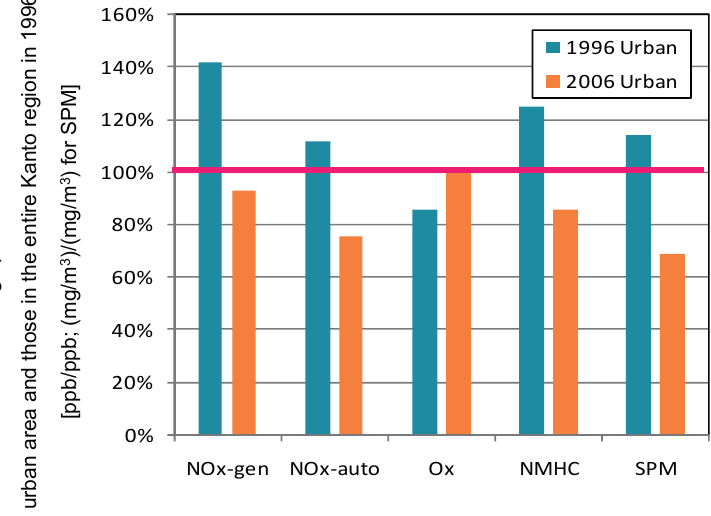
Figure 10. Ratio between average pollutant concentrations in urban area and those in entire Kanto region during 1996. Average concentration of entire Kanto region in 1996 corresponds to 100%.